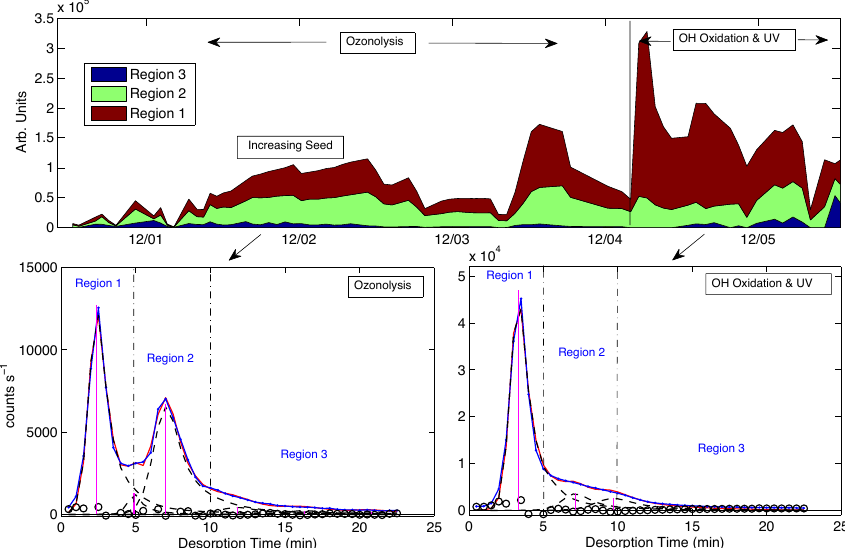
Fig. 7. An example of thermogram fitting using the C 8 H 11 O 4 - desorption signal from particles collected at JPAC. Bottom left: a thermogram from α -pinene ozonolysis is shown. The total raw signal is shown as a blue line with dots. Individual desorption peaks used to fit the total signal are shown as dashed lines with locations of the maxima indicated by vertical magenta lines. The sum of the fitted desorption peaks is shown as a red line and the residual between the signal and fitted thermogram is shown as open circles. Bottom right: a thermogram from α -pinene oxidation by OH and the corresponding fits are shown – colors and symbols are the same as at the left. Although the location (in time or temperature) of the fitted desorption peaks are mostly similar for the two periods, for simplicity the fitted thermograms are divided into three regions for comparing the relative signal in the different portions of the thermogram. Top: the time series constructed from the thermogram fits using the three integration regions shown in the lower panels. Evident is the difference in absolute magnitude of the ratio of signal in Region 1 and Region 2, between ozonolysis with variable seed and OH oxidation, suggesting the thermograms track changes in the chemical or physical properties of the aerosol given changes in formation and processing